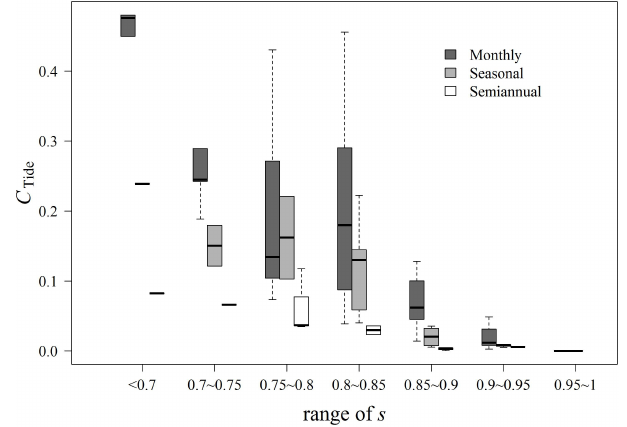
Fig. 4. Vertical dashed lines show the typical ranges of variance of T a (air temperature) on three temporal scales. Dotted curves show the boundaries of Q 10 distribution. Different colors represent dif- ferent levels of C T (relative importance of air temperature). a